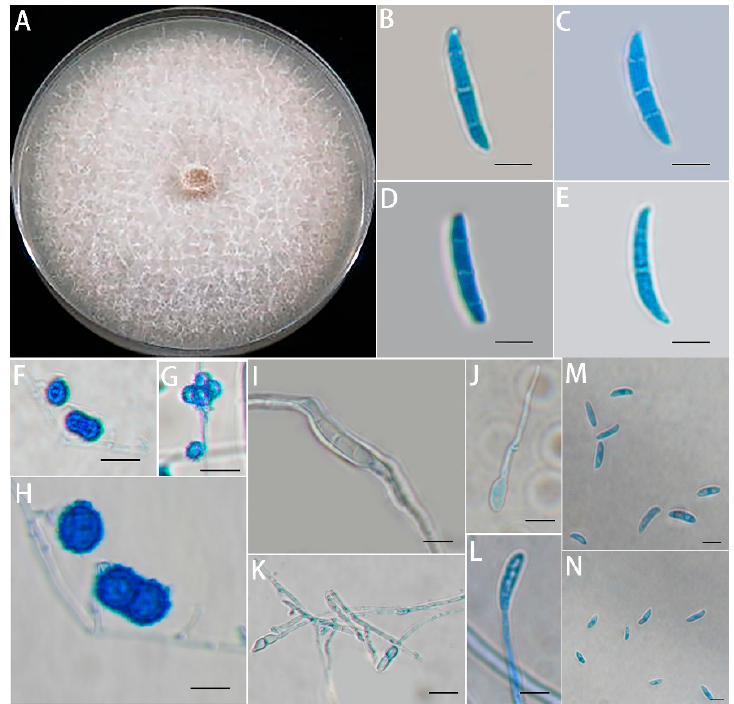
Figure 2. Culture characteristics and microscopic appearance of isolates. ( A ) Appearance of isolates in pure culture on potato dextrose agar medium; ( B – E ) macroconidia; ( F – H ) chlamydospores; ( I – L ) monophialides; and ( M , N ): microconidia. Scale bars: ( F , G , K ) 20 μ m; ( B – E , H – J , L – N ) 10 μ m. Table 2. Effect of mixed cropping with A. fistulosum L. on the biomass of the grafted apple seedlings. Sampling Time Treatment Plant Height (cm) Fresh Weight (kg) The first